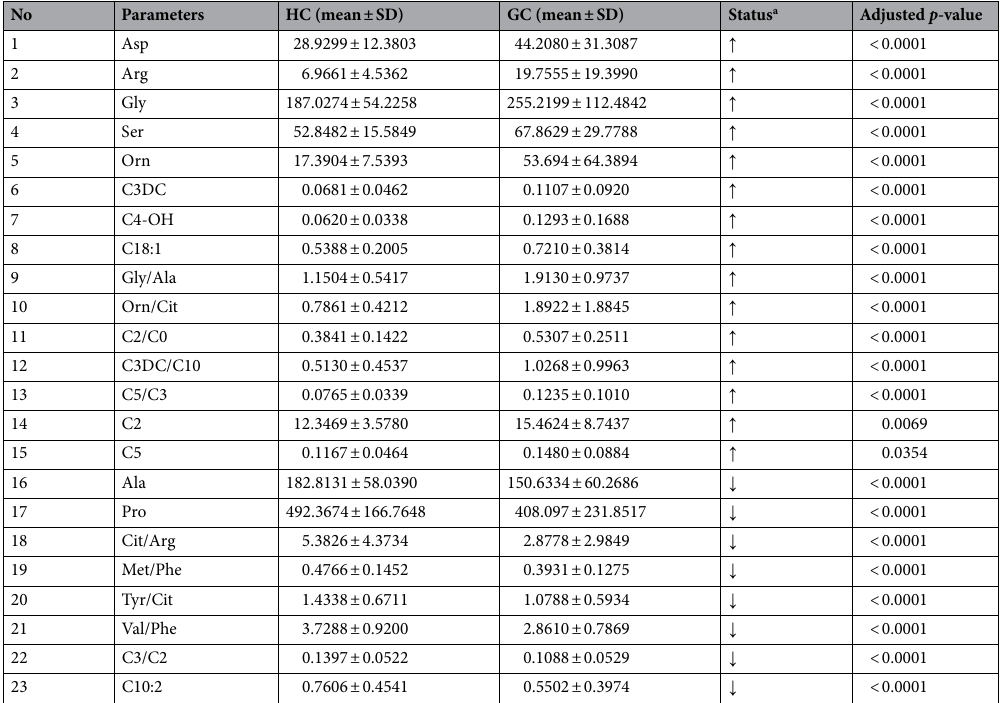
Table 2. The differential parameters between patients with GC and healthy individuals. HC, healthy control; GC, gastric cancer; Asp, aspartic acid; Arg, arginine; Gly, glycine; Ser, serine; Orn, ornithine; C3DC, malonylcarnitine; C4-OH, hydroxybutyrylcarnitine; C18:1, octadecenoylcarnitine; Ala, alanine; Cit, citrulline; C2, acetylcarnitine; C0, free carnitine; C10, decanoylcarnitine; C5, isovalerylcarnitine; C3, propionylcarnitine; Pro, proline; Met, methionine; Phe, phenylalanine; Tyr, tyrosine; Val, valine; C10:2, decadienoylcarnitine. a Defined as the increased (upward arrow) or decreased (downward arrow) levels of metabolites in patients with GC compared to healthy individuals.